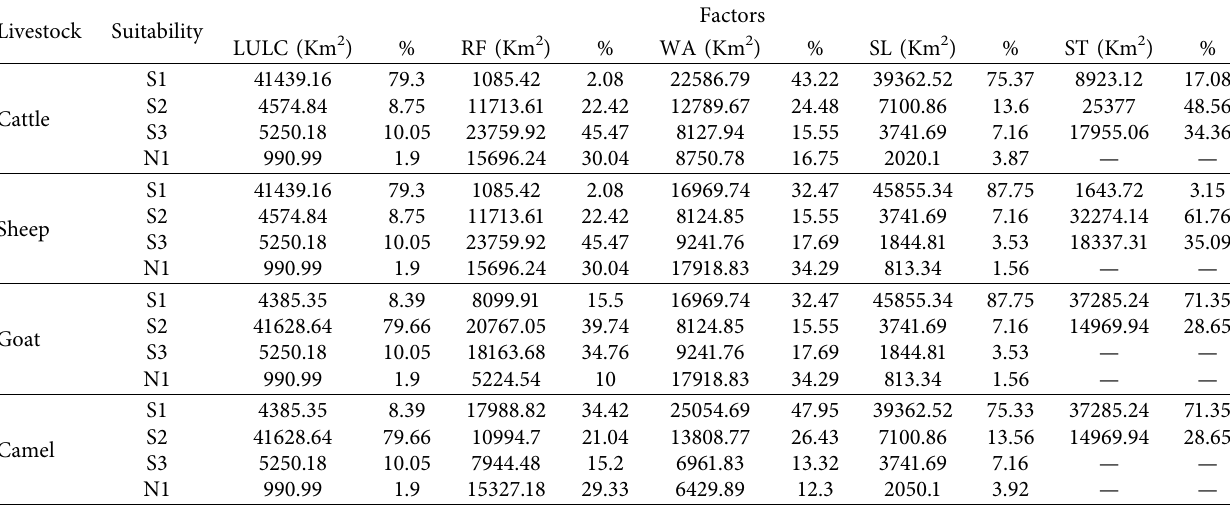
Table 3: Rangeland suitability evaluation factors and their suitability classes and aerial